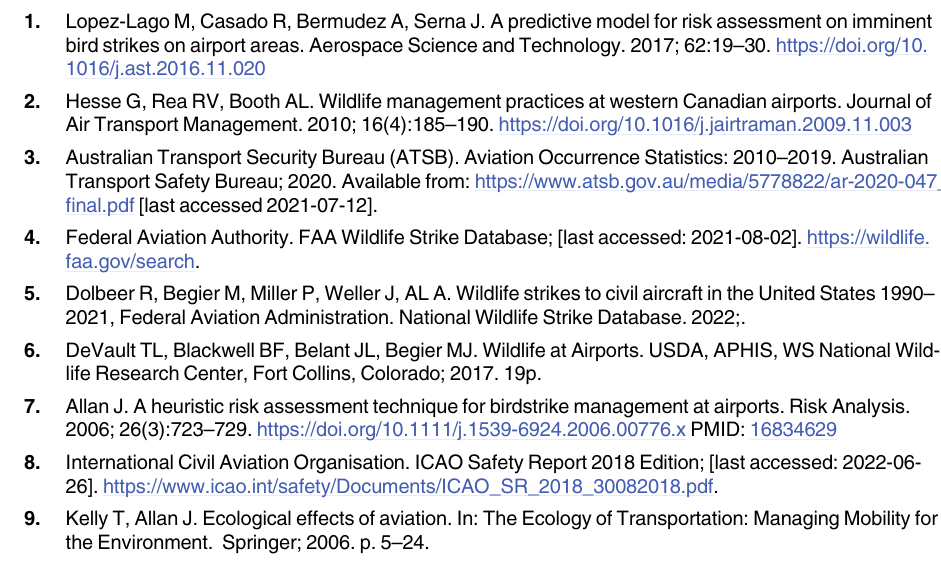
S2 Table. Complete listing of the two principal components, including variable loadings, responsible for the greatest variation as used in clustering models. S3 Table. Configuration parameters for the gaussian and sigmoid functions used in Alge- braic models for each of the hazard species, and the ‘day 0’ value for each of the hazard spe-